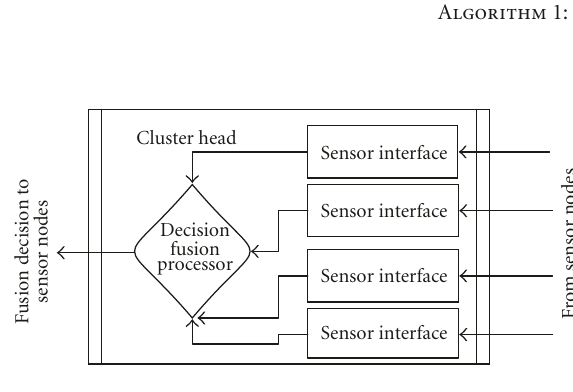
Figure 6: Generic cluster head